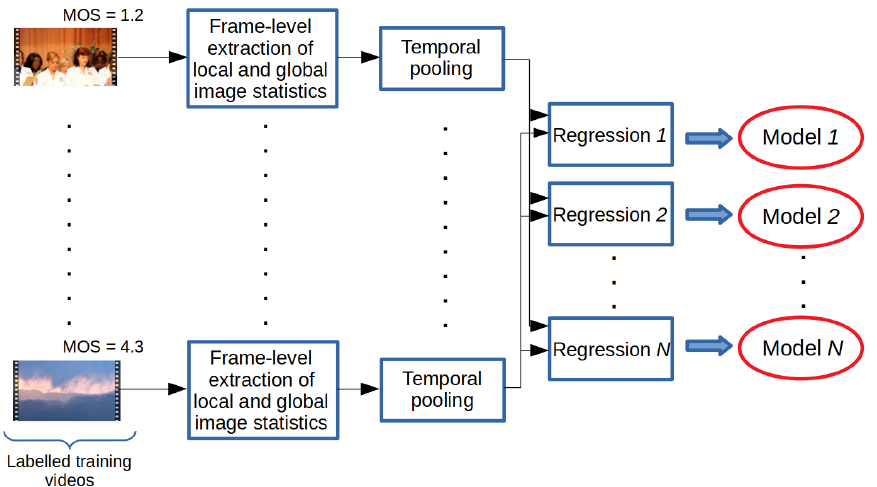
Figure 1. Training process of the proposed method. Video-level feature vectors are obtained from labeled training videos through the temporal pooling of local and global image statistics. Next, several regressors are trained.